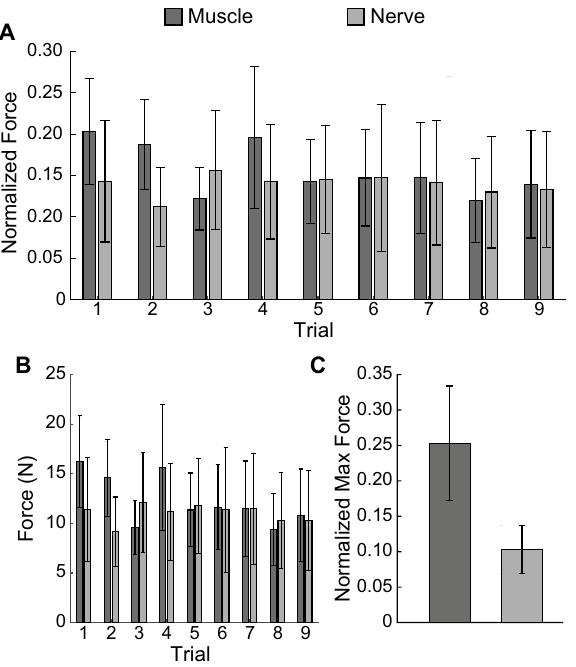
Figure 6. ( A ) The max force per trial normalized by each participant’s MVC and averaged across participants ( n = 8) has similar magnitude throughout the experimental block for nerve (light gray bar) and muscle stimulation (dark gray bar). ( B ) The max forces of each trial were also similar magnitudes without normalization. ( C ) No significant difference was found between the maximum force evoked by muscle (n = 8) and nerve stimulation (n = 7), although the maximum force exerted by nerve stimulation tended to be much less than that exerted by muscle stimulation ( p = 0.13, unpaired t-test). Bars show mean ± standard error of the